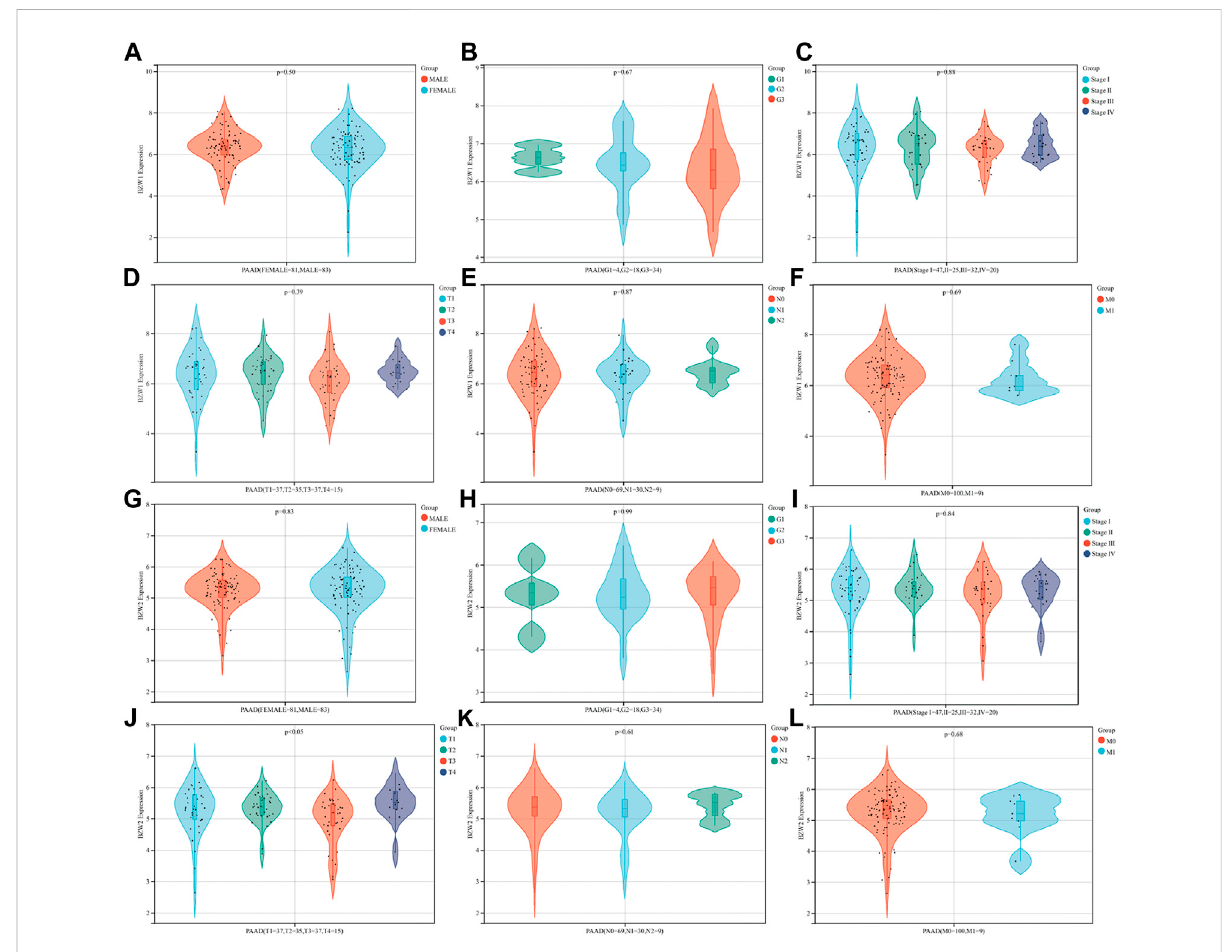
FIGURE 3 Relationships between BZW1/2 expression and clinicopathological parameters of PAAD. The expression of BZW2 in patients with T3 stage disease was higher than in T2 and T4 stage (J) . BZW1 and BZW2 expression were not signi fi cantly associated with gender (A,G) , grade (B,H) , AJCC stage (C,I) and TNM stage (D,E,F,K,L) of PAAD